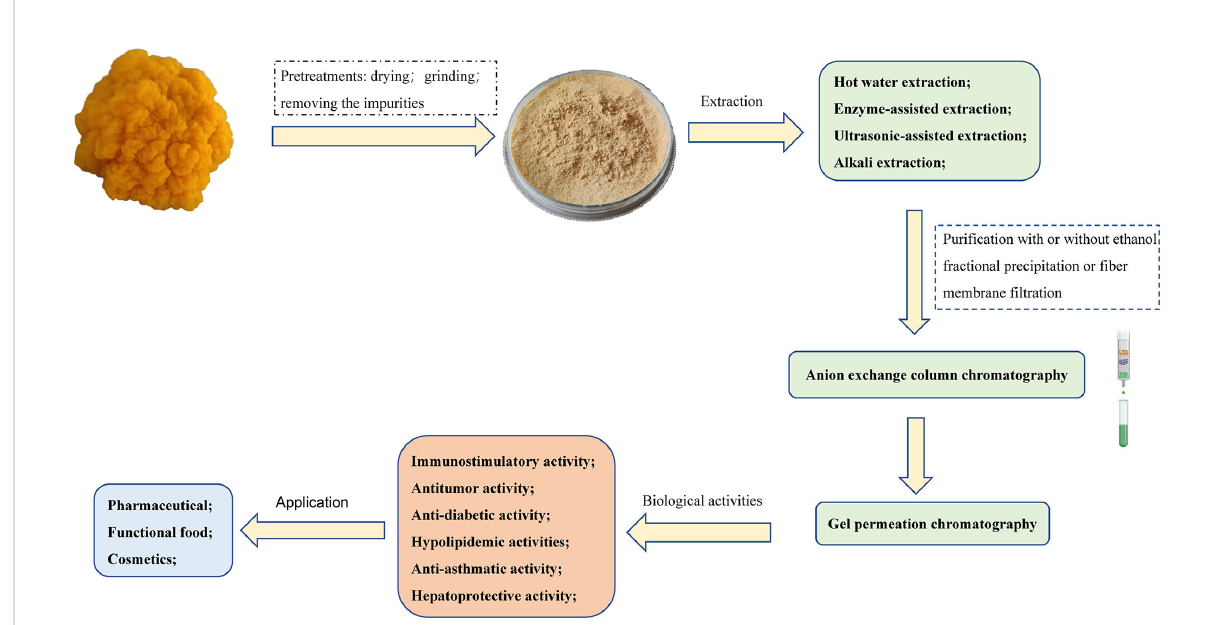
FIGURE 4 Schematic representation of the extraction, puri fi cation, biological activities and applications of T. aurantialba